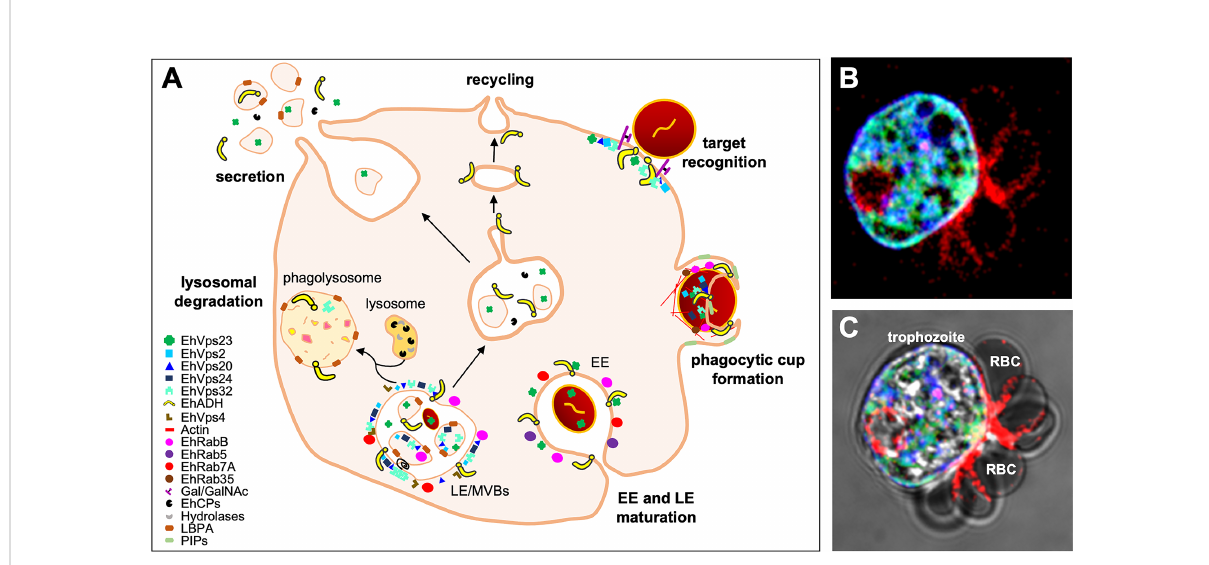
FIGURE 5 The ESCRT machinery in the endosomal compartments during phagocytosis. (A) Phagocytosis begins with the RBCs recognition. RBCs are internalized through the phagocytic cup to generate EE that eventually will mature into LE/MVBs. These structures fuse to lysosomes for producing phagolysosomes, where the molecules are fi nally degraded. In parallel, some proteins as receptors are recycled to the PM to be reused for new endocytosis rounds. On the other hand, in order to modulate the communication with other trophozoites or for damaging host cells, E . histolytica secretes molecules to the extracellular medium, such as ESCRT proteins, EhCP112, amoebapores and LBPA, among others. In general, several ESCRT members have been detected in different types of endosomes or vesicles, suggesting their active participation during the endocytic pathway, recycling and secretion. (B, C) Immuno fl uorescence assays and confocal microscopy of trophozoites ingesting RBCs. Images show EhADH (green), EhVps32 (blue) and actin (red) at the PM, particularly at the contact site with RBCs. In addition, these proteins are also located around ingested RBCs and in some intracellular structures. (C) Overlapping image of fl uorescence channels plus phase contrast evidencing the trophozoite and RBCs